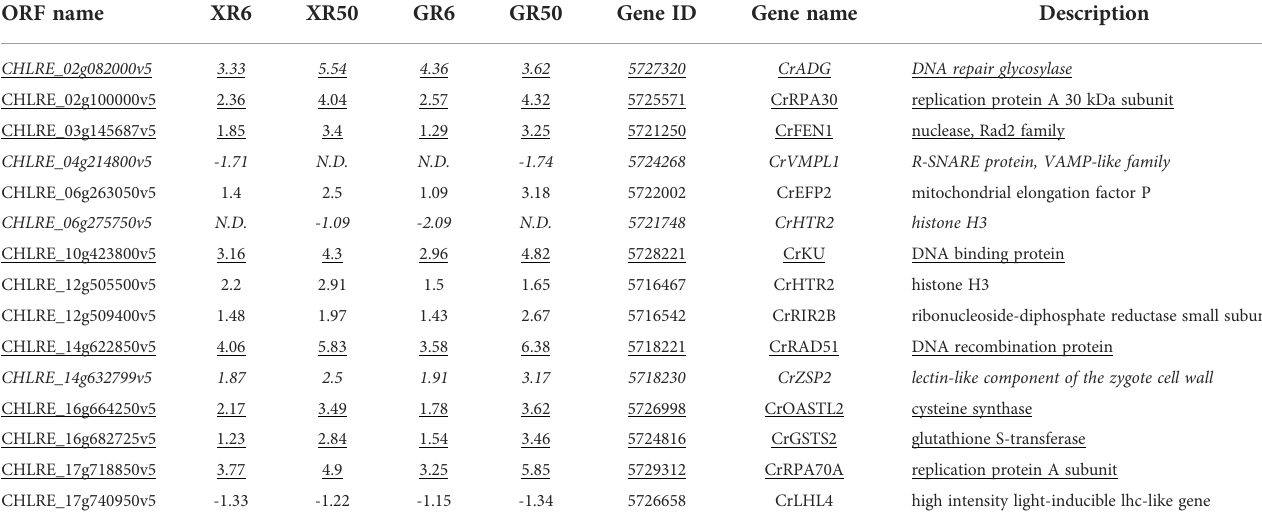
TABLE 1 Transcriptomic pro fi les of C. reinhardtii cells after X- or g -irradiation with two different doses.